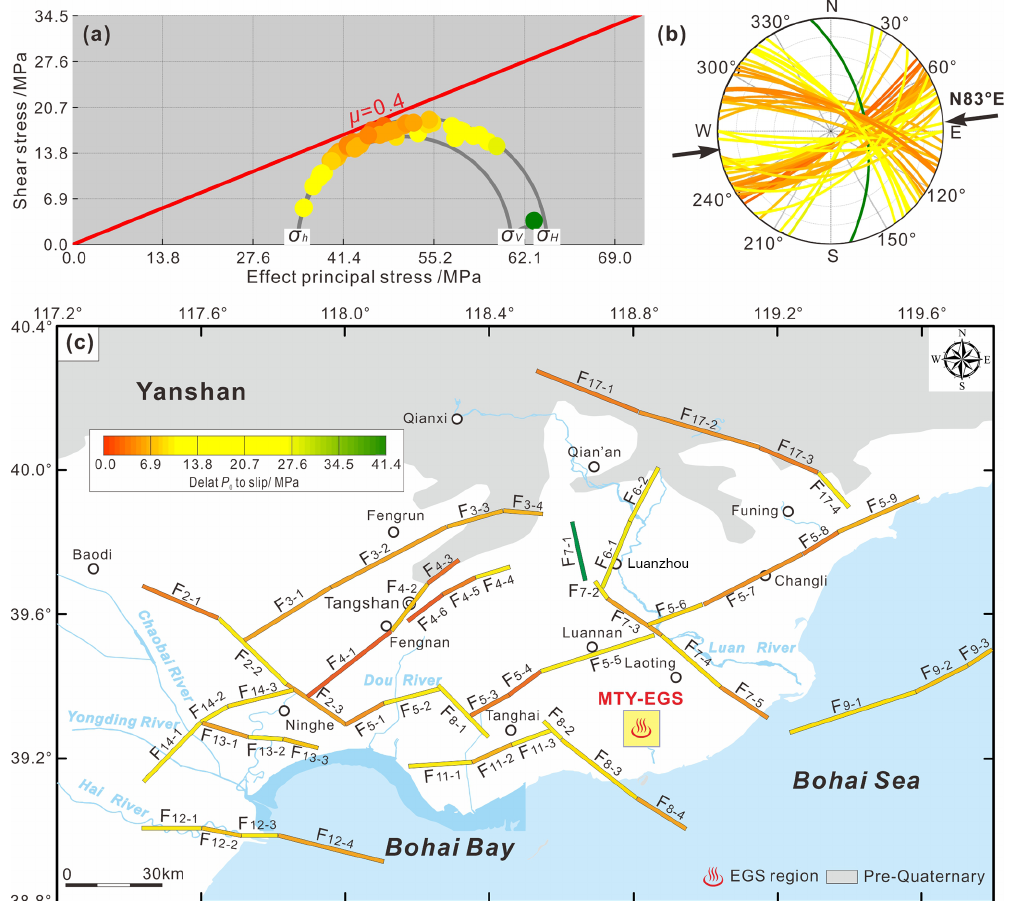
Figure 7. The results of a deterministic geomechanical assessment of fault pore pressure to slip across the Tangshan seismic region. (a) The faults shown on a Mohr diagram, with effective compressive stress on the horizontal axis and shear stress on the vertical axis; principal stresses are labeled in black, and the frictional slip line is shown in red. Faults are colored by their horizontal distance to slip in megapascals (according to the color scale). (b) Fault-normal orientations plotted on a lower-hemisphere equal-angle stereonet as arcs; the azimuth of maximum horizontal compression is shown with black arrows. (c) The same faults mapped and colored by deterministic fluid pore pressure to